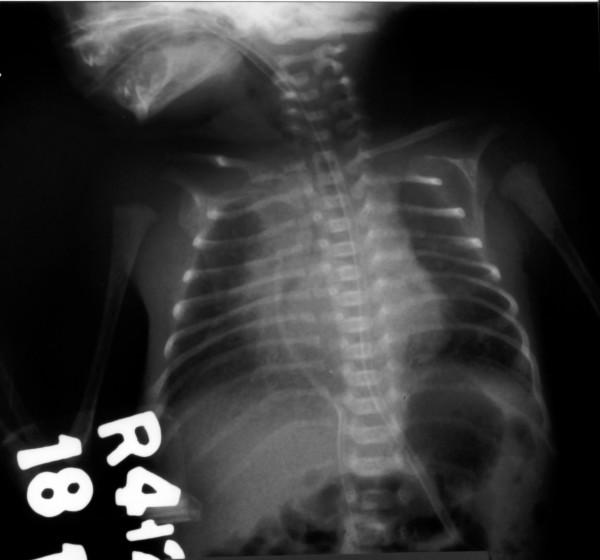
X-ray chest with mandible showed absence of calcified crowns of the first and second deciduous molar in Twin A.